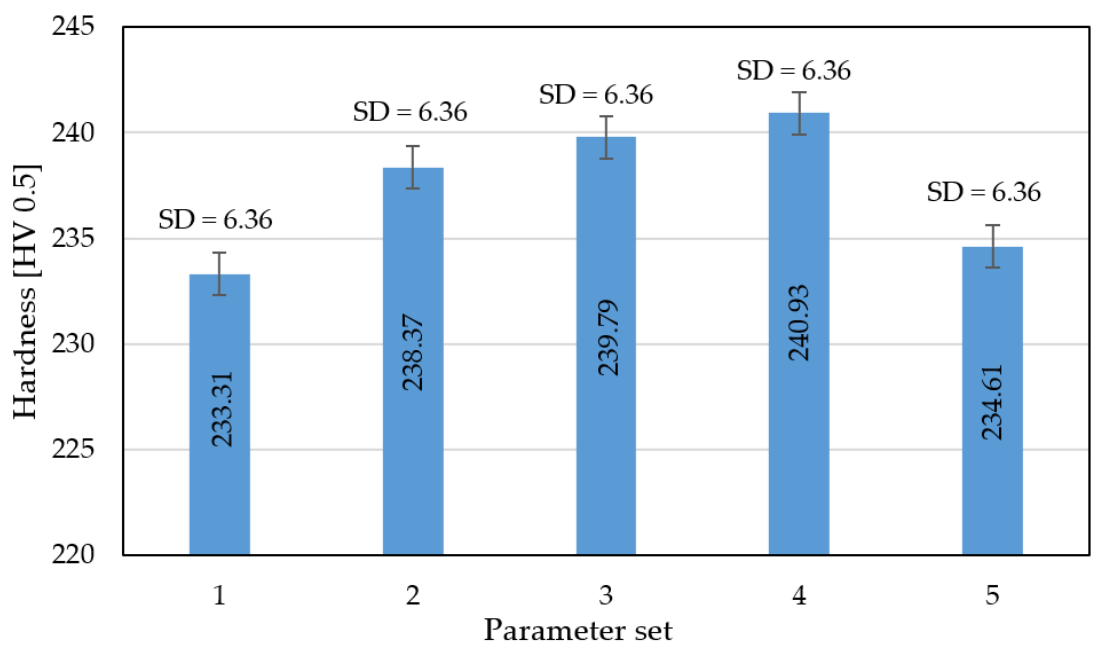
ff erent values of energy